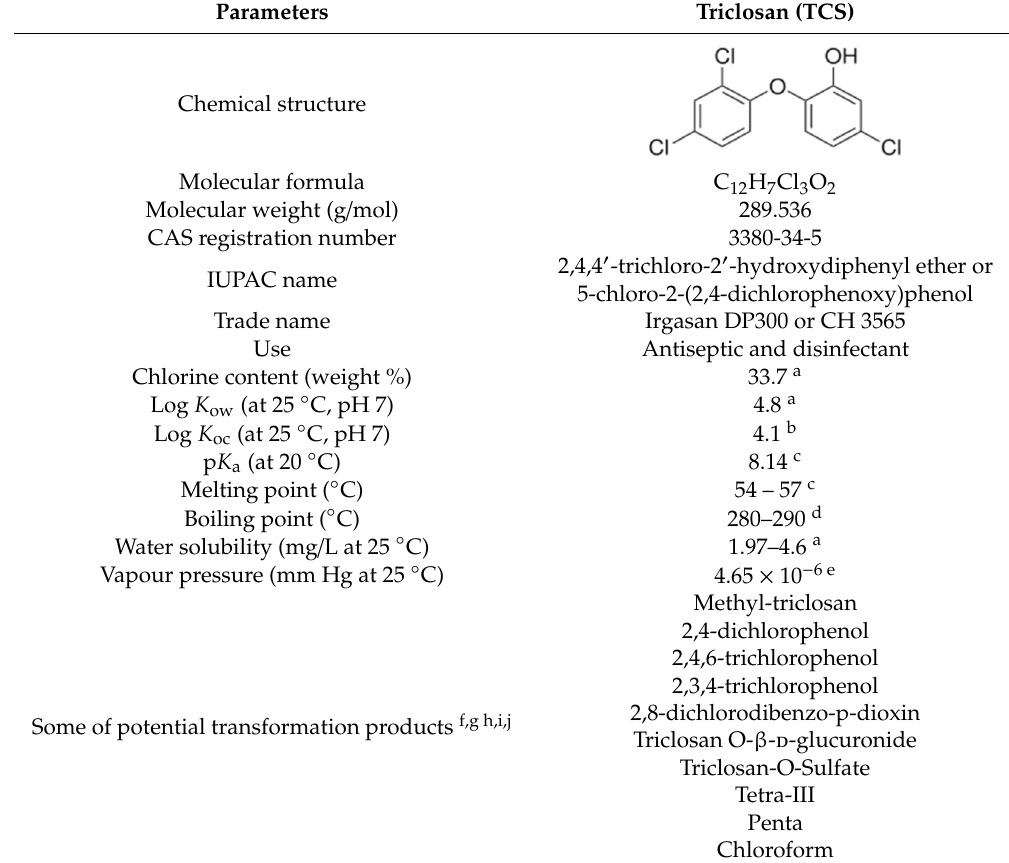
Table 1. Key physical and chemical properties of triclosan.